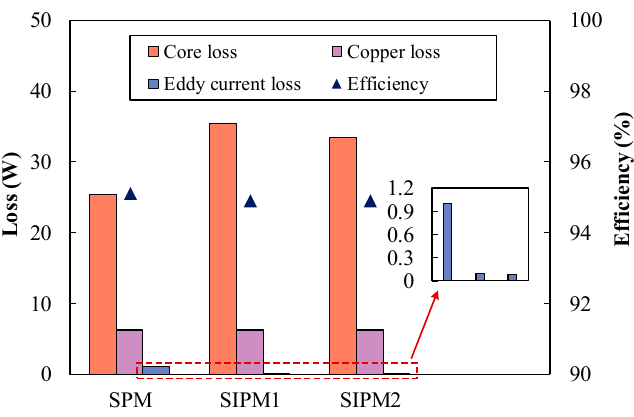
Figure 14. Energy loss and efficiency.